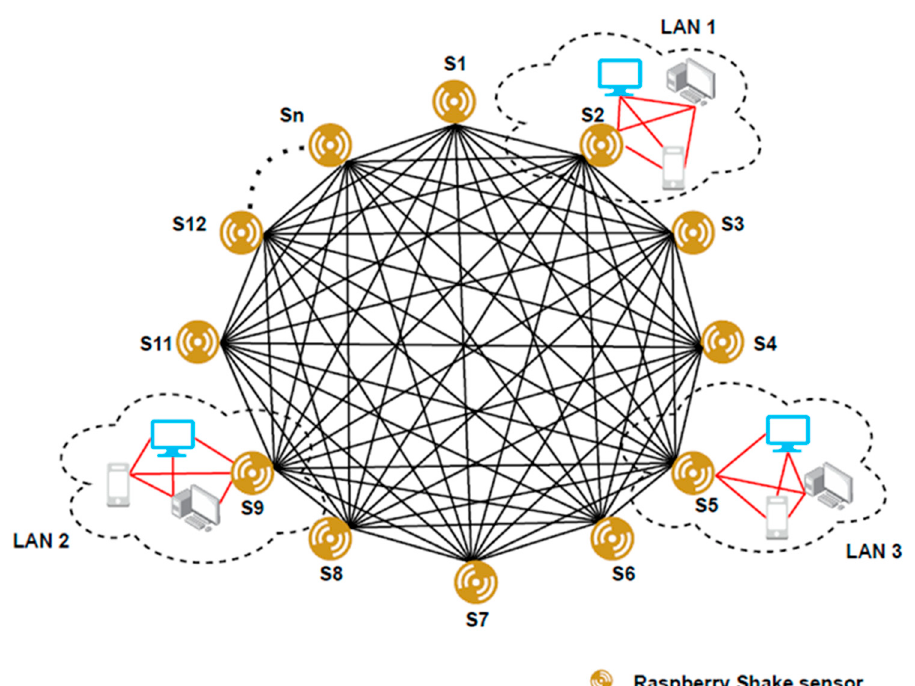
Figure 2. The proposed decentralised architecture consists of Raspberry Shake sensors installed in different Local Area Networks, which are connected to each other via the internet.